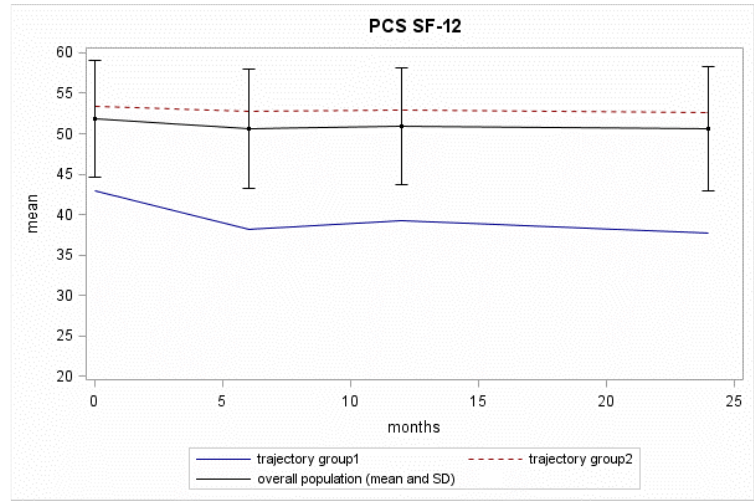
Figure 3. The PCS SF-12 scores across the timeline of the 4 evaluations for the Pros-IT participants. Two trajectories for the PCS scores in the Pros-IT participants were identified (Figure 3; Table S3): Table 3. Predictors of the trajectory class membership for the Physical Composite Score